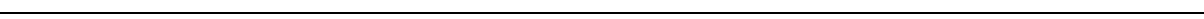
Fig. 2 Subclonal evolution of four breast cancers over 2 – 15 years. a – d Subclonal evolution of breast cancer patients #1 to #4 through treatment. Left side shows variant allele frequencies of copy-neutral somatic SNVs and indels (WGS) organized into clusters, with relevant cancer-associated mutations (may or may not be copy-neutral and includes structural variants) indicated. Right shows subclone evolution. Subclones are indicated by large circles; mutation clusters are indicated by small colored circles. Relevant mutations in subclones are indicated by text or boxed insets. CCF is indicated as percent next to subclone. Filled squares indicate timepoints sequenced by whole-genome sequencing (WGS), fi lled inverted triangles indicate whole-exome sequencing (WES), and empty squares indicate targeted single-cell DNA sequencing (scDNA). Abr, Abraxane; cap, capecitabine; cb, carboplatin; dox, doxorubicin; erib, eribulin; exem, exemestane; fulv, fulvestrant; gem, gemcitabine; Tax, paclitaxel; trast, trastuzumab; vinorel, vinorelbine. *Patient #3 day 0 had RNA- Seq only. gBRCA2 indicates a germline BRCA2